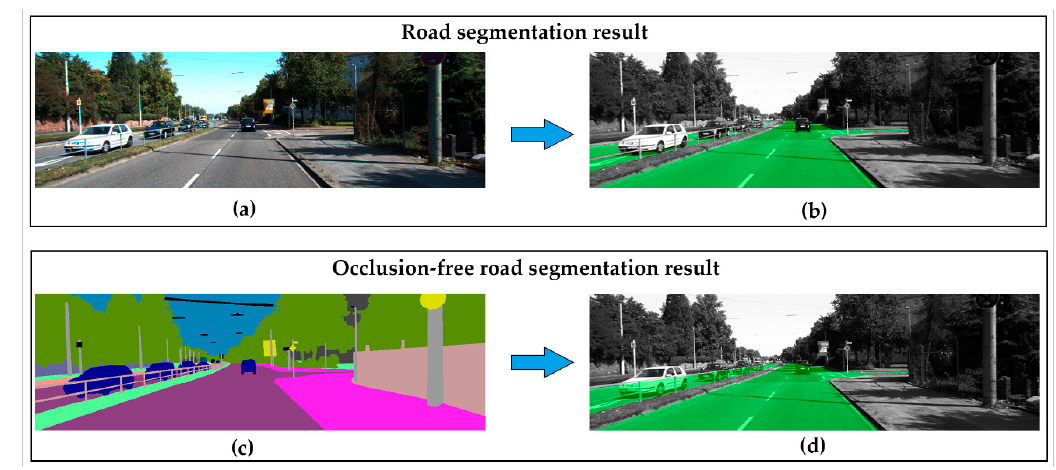
Figure 1. Comparison of road segmentation and proposed occlusion-free road segmentation. ( a ) RGB image; ( b ) visualization of the results of road segmentation; ( c ) visualization of the semantic representation of the scene, which could be obtained by semantic segmentation algorithms in real applications or human annotation in training phase; ( d ) visualization of the results of the proposed occlusion-free road segmentation. Green refers to the road area in ( b ) and ( d